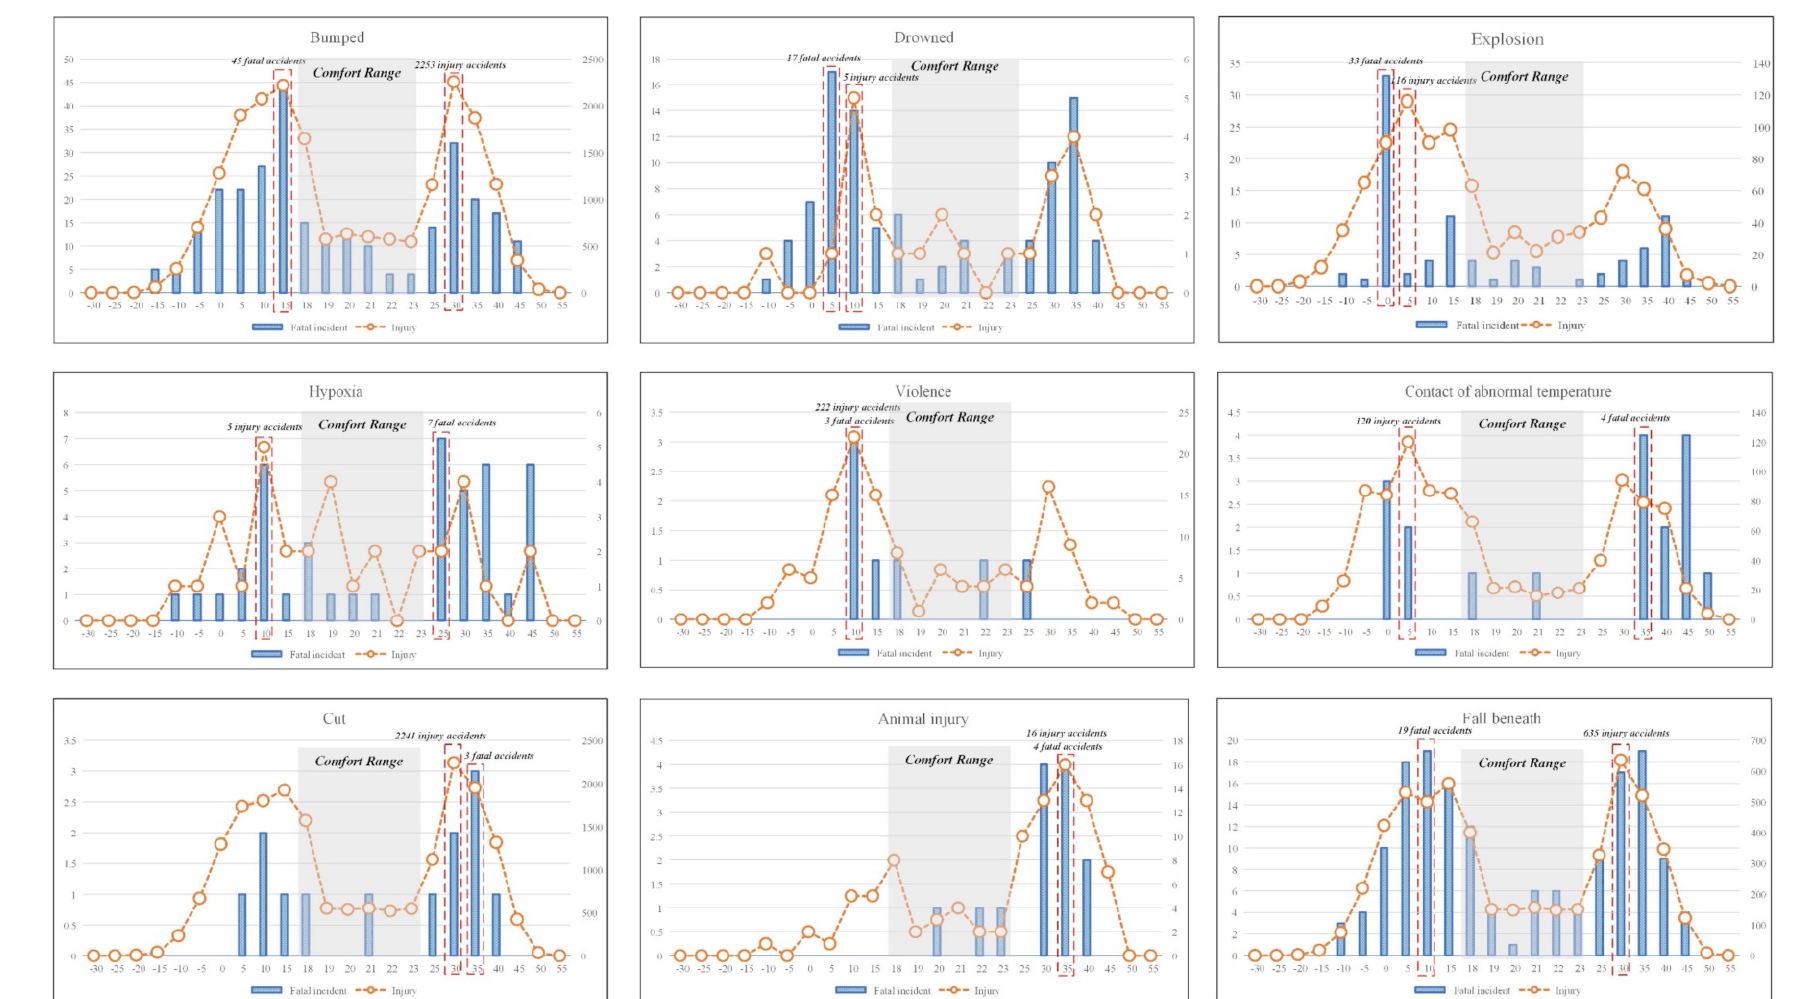
Figure 6. Graph of injury and fatal accidents types based on PET